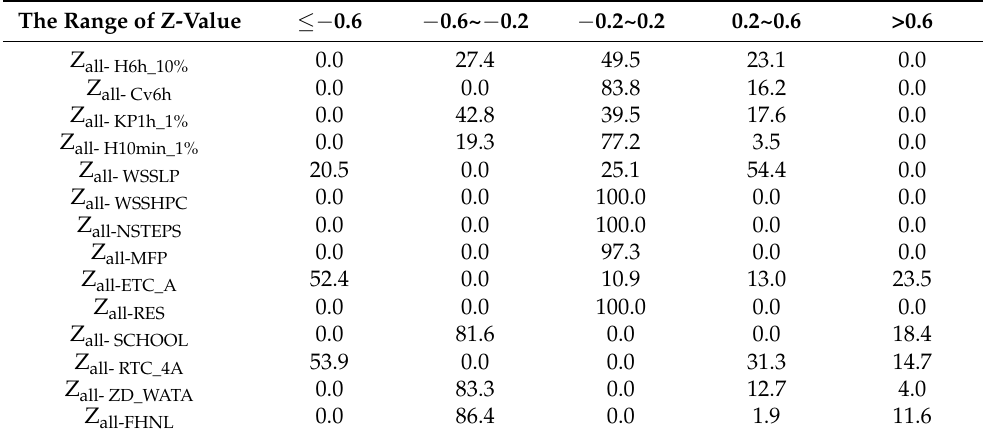
Table 12. Statistical Percentage of Z-values without Considering a Single Factor. The Range of Z-Value